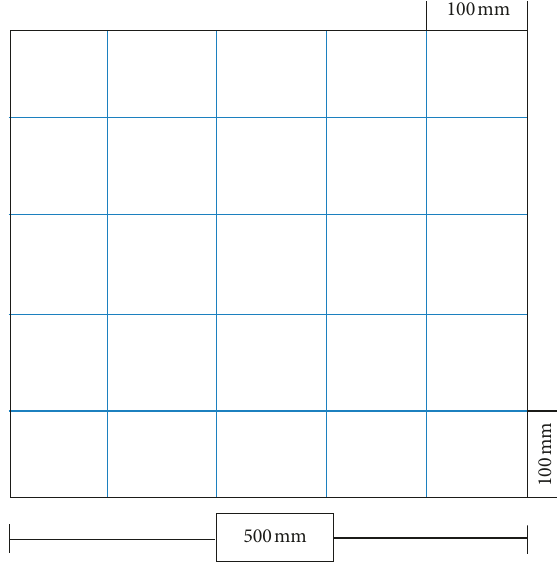
Figure 2: Sample cutting